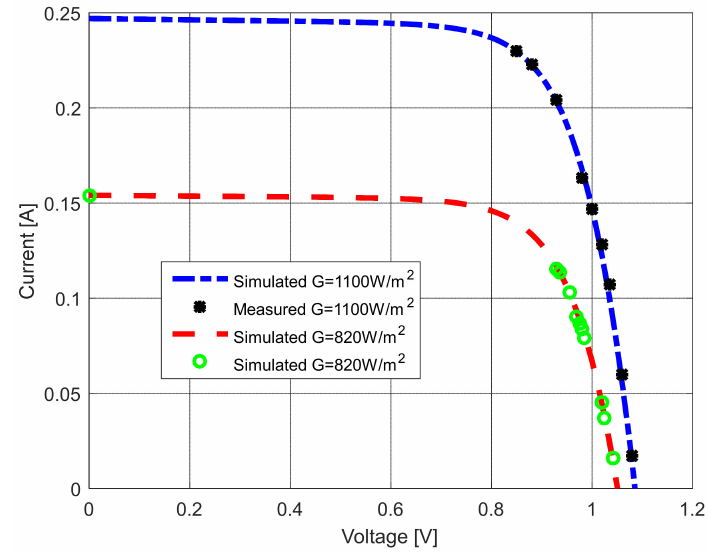
Figure 28. The measured and simulated I–U characteristics using different irradiance values.